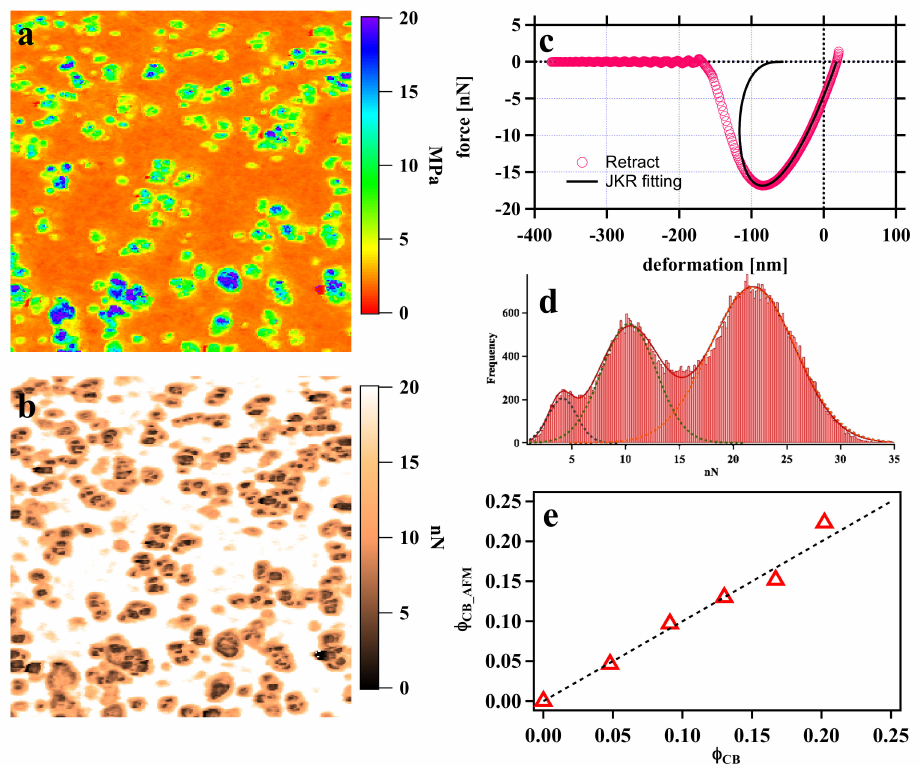
Figure 2. ( a , b ) Young’s modulus and adhesion force mapping of CB (4.9%, 10 phr)/IR obtained by PeakForce QNM AFM. The scan size was 3.0 µ m; ( c ) typical force − deformation curve. The Young’s modulus results from a fit of the retracing curve with a JKR contact model, as indicated by the solid black line. ( d ) Histograms of adhesion force mapping for CB (4.9%, 10 phr)/IR. ( e ) Volume fraction of CB from PeakForce QNM AFM and the real